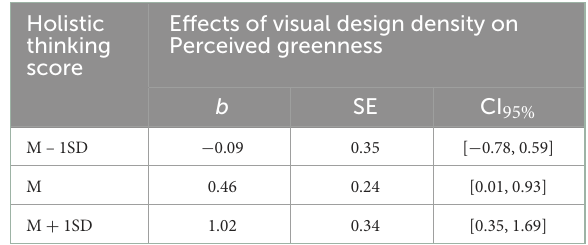
TABLE 1 The moderation effect of holistic